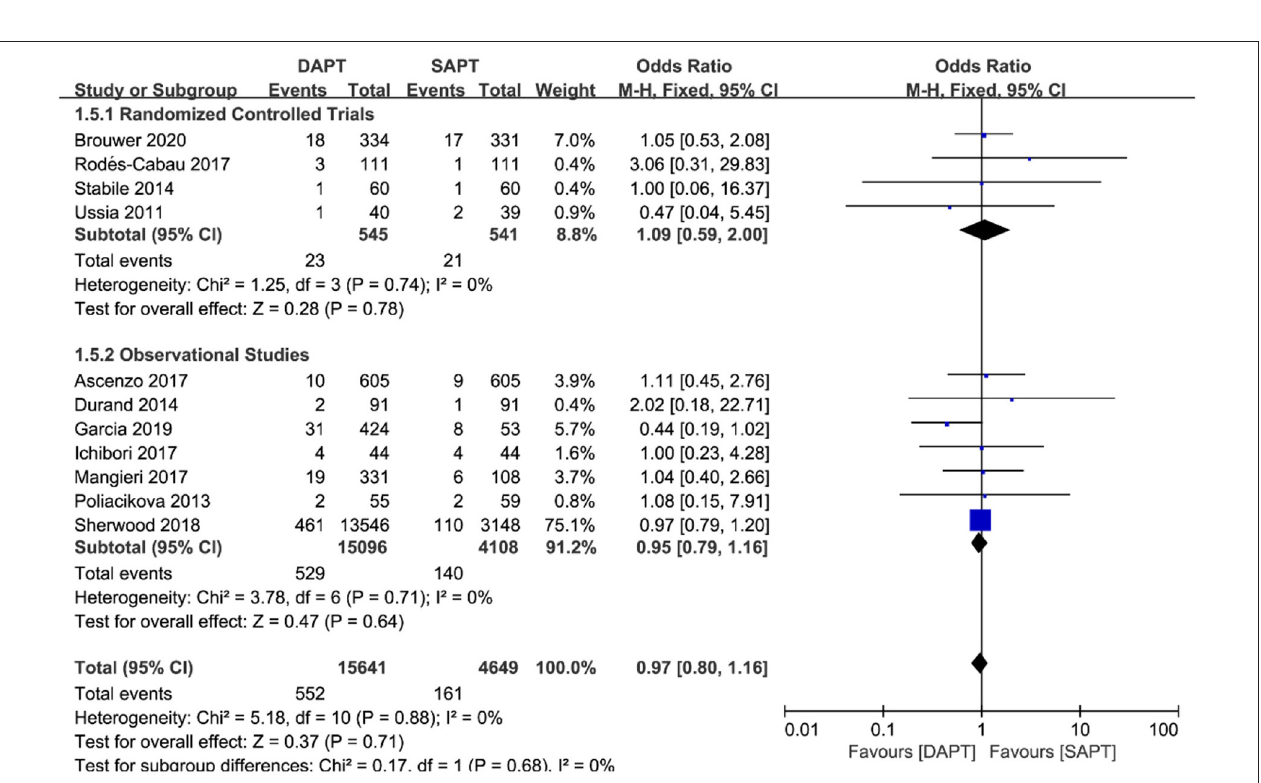
FIGURE 7 | Forest plot for stroke with subgroup analysis stratified by study type at longest follow-up.